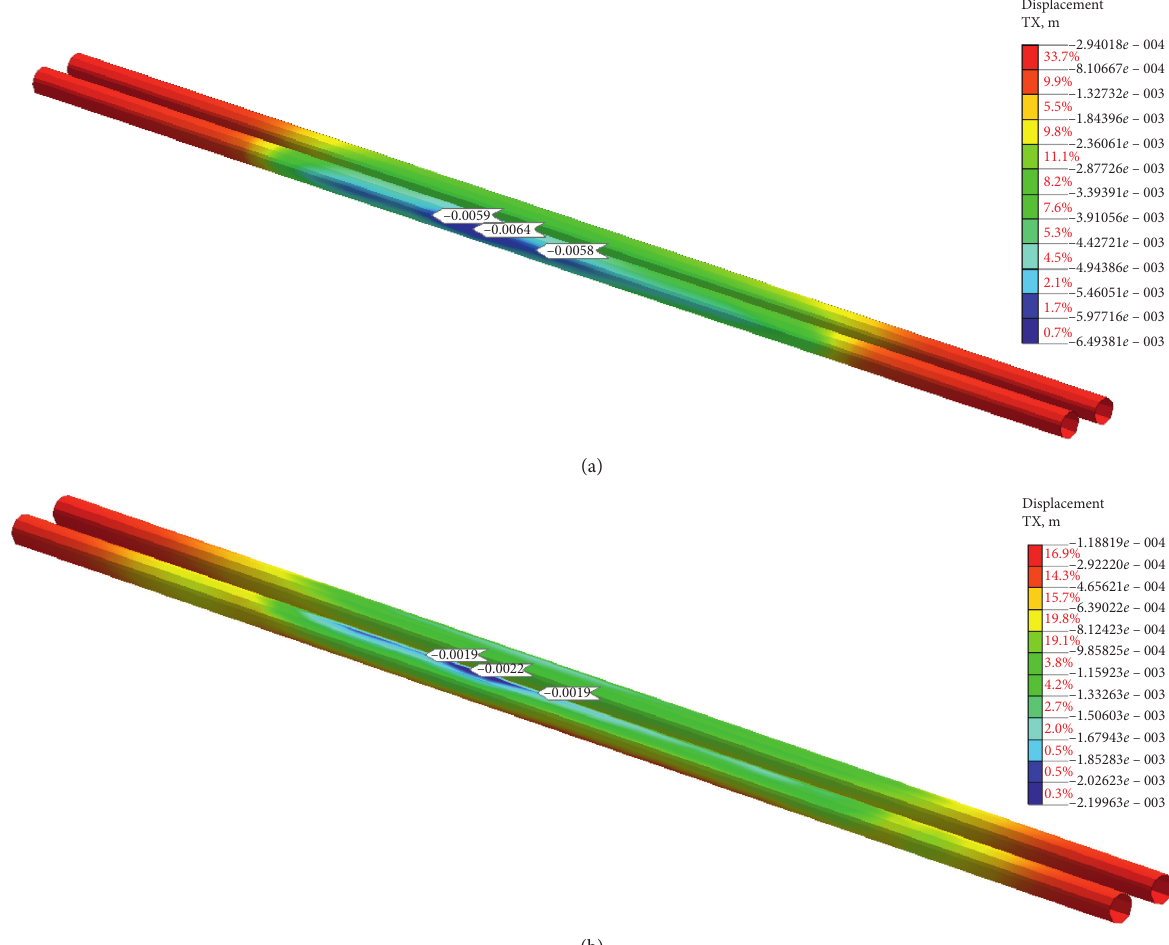
Figure 15: Maximum deformation position of the tunnel: (a) horizontal direction; (b) vertical